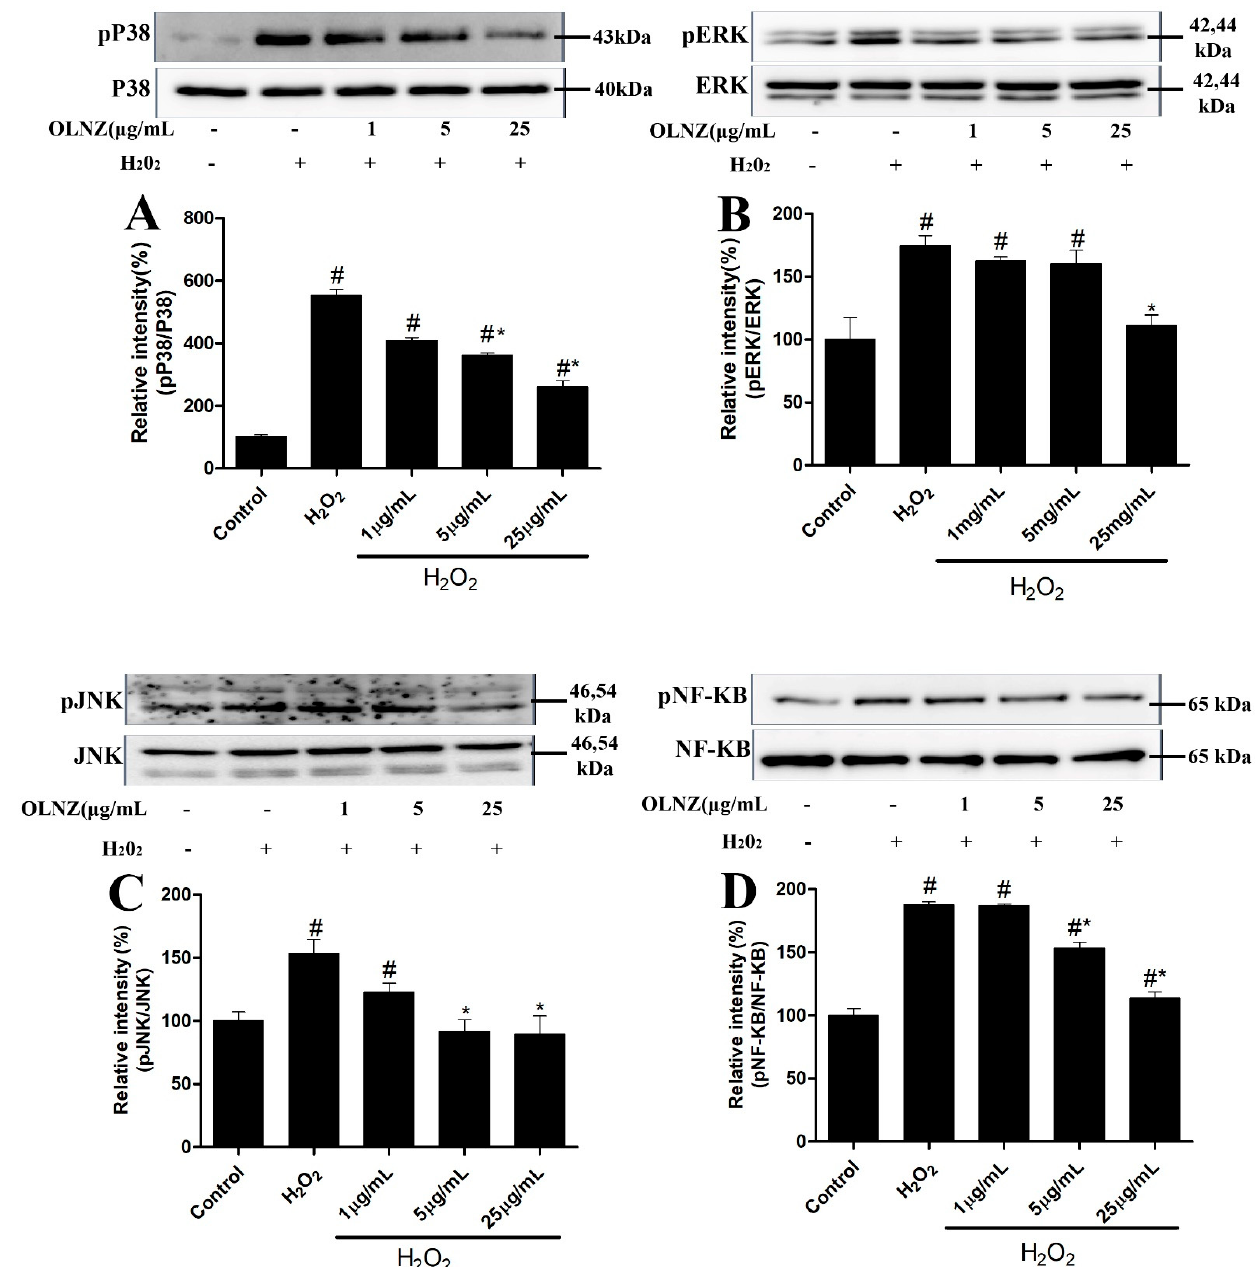
Figure 12. Protective role of OLNZ against the H 2 O 2 -mediated phosphorylation of ERK, JNK, p38, and NF-KB protein in SH-SY5Y cells. The expression (% of ( A ) pP38, ( B ) pERK, ( C ) pJNK, and ( D ) pNF-KB proteins decreased after pretreatment with OLNZ in H 2 O 2 -induced SH-SY5Y cells. Data were presented as the mean ± SEM, and the experiment was repeated three times. (#) compared to the control and (*) compared to H 2 O 2 , p < 0.05.